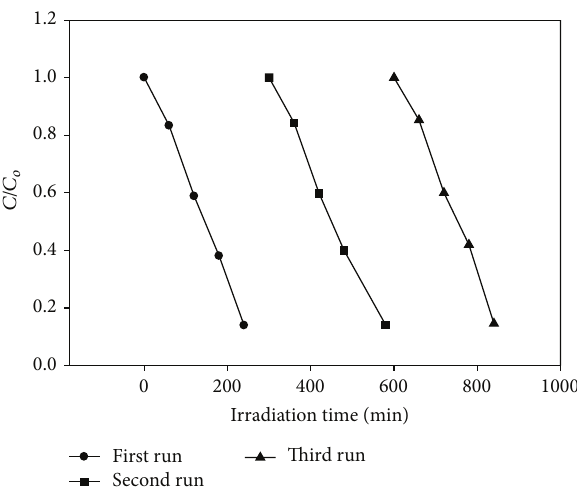
Figure 12: Recycled photocatalytic degradation of eosin Y.